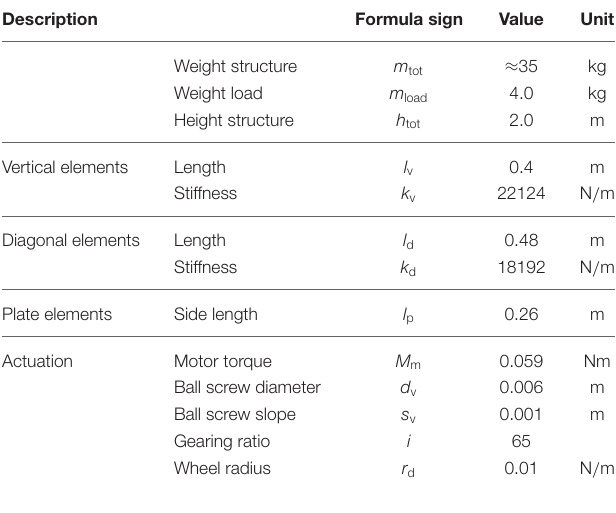
TABLE 1 | Geometry and material parameters of the scale model.